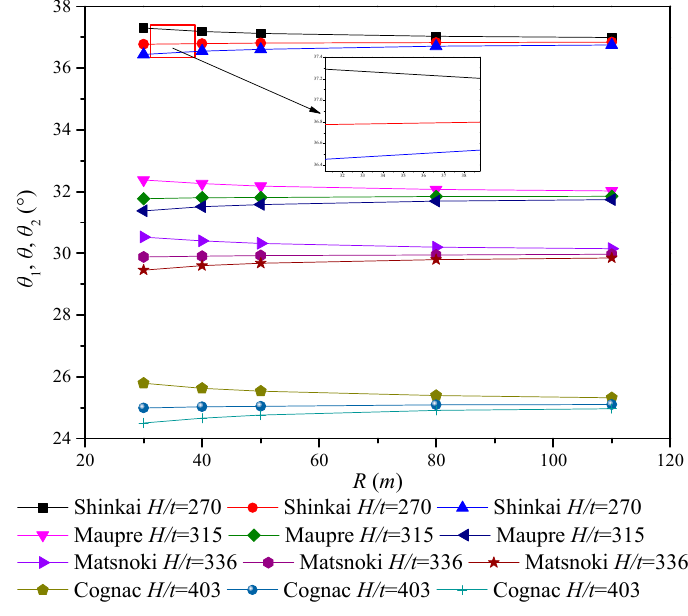
Figure 15. Different angles θ 1 , θ and θ 2 versus curvature radius R. Appl. Sci. 2018 , 8 , x FOR PEER REVIEW